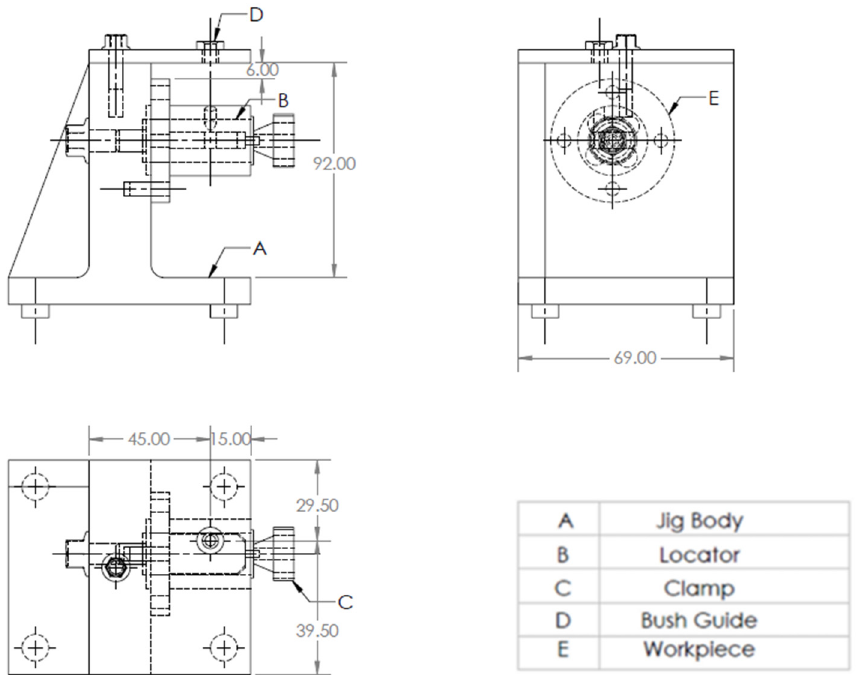
Figure 25. A drawing for the required jig design of the part.